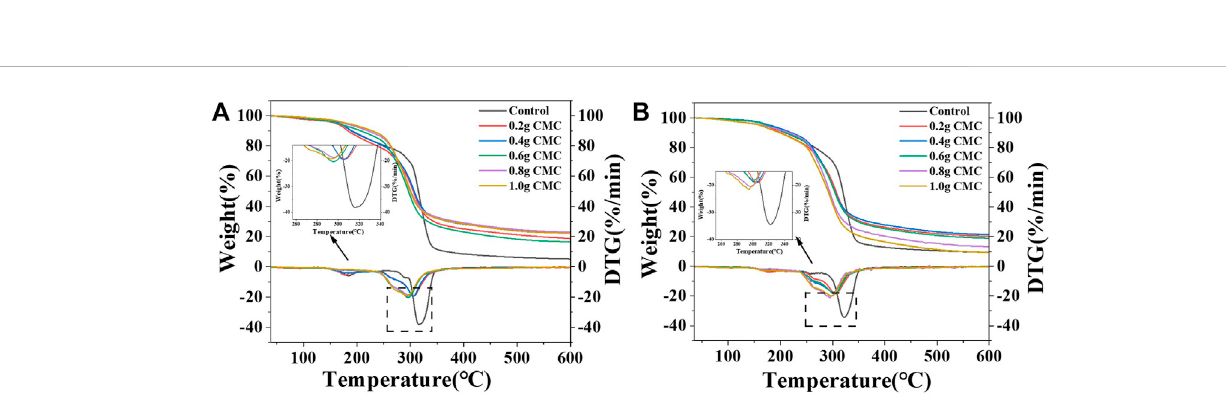
FIGURE 5 TG and DTG curves of the starch/CMC composite fi lm. (A) : CS/CMC composite fi lms; (B) : CA/CMC composite fi lms.